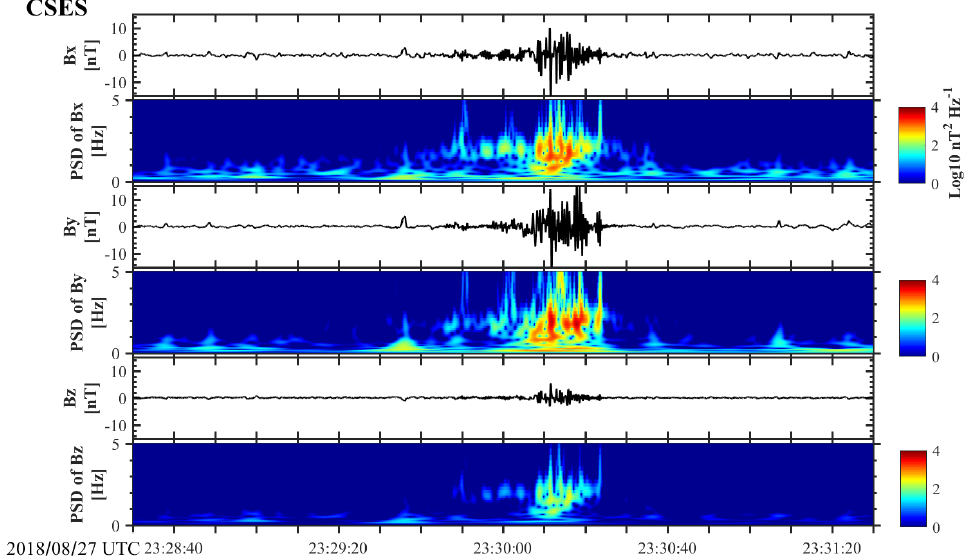
Figure 5. The power spectral densities (PSDs) of the magnetic fields in the local NED coordinates during the Pc1 wave period (23:30– 23:31UTC) observed by the